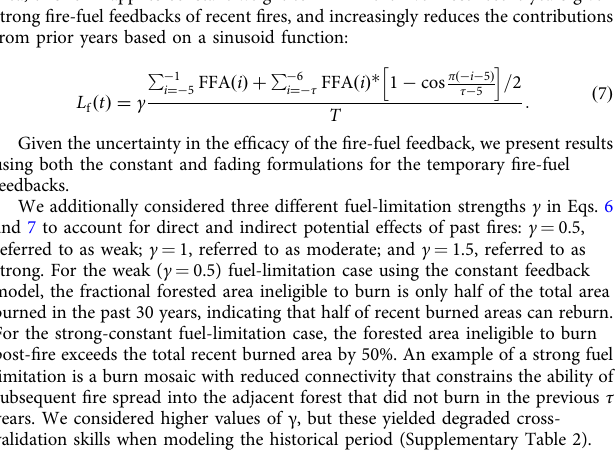
Fig. 4c. In the case of the constant feedback, the effect of burned area on L f remains constant over the τ years following fi re. At the scale of the whole western US forested area, the constant form, therefore, assumes that the transient limitation is simply proportional to the total FFA over the preceding τ years: In Eq. 6, parameter γ represents the strength of the feedback, described in more depth below.